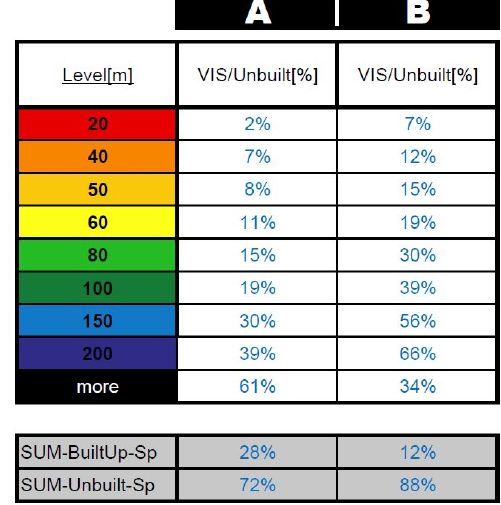
Table 3. Comparison of VIS simulations for area A and